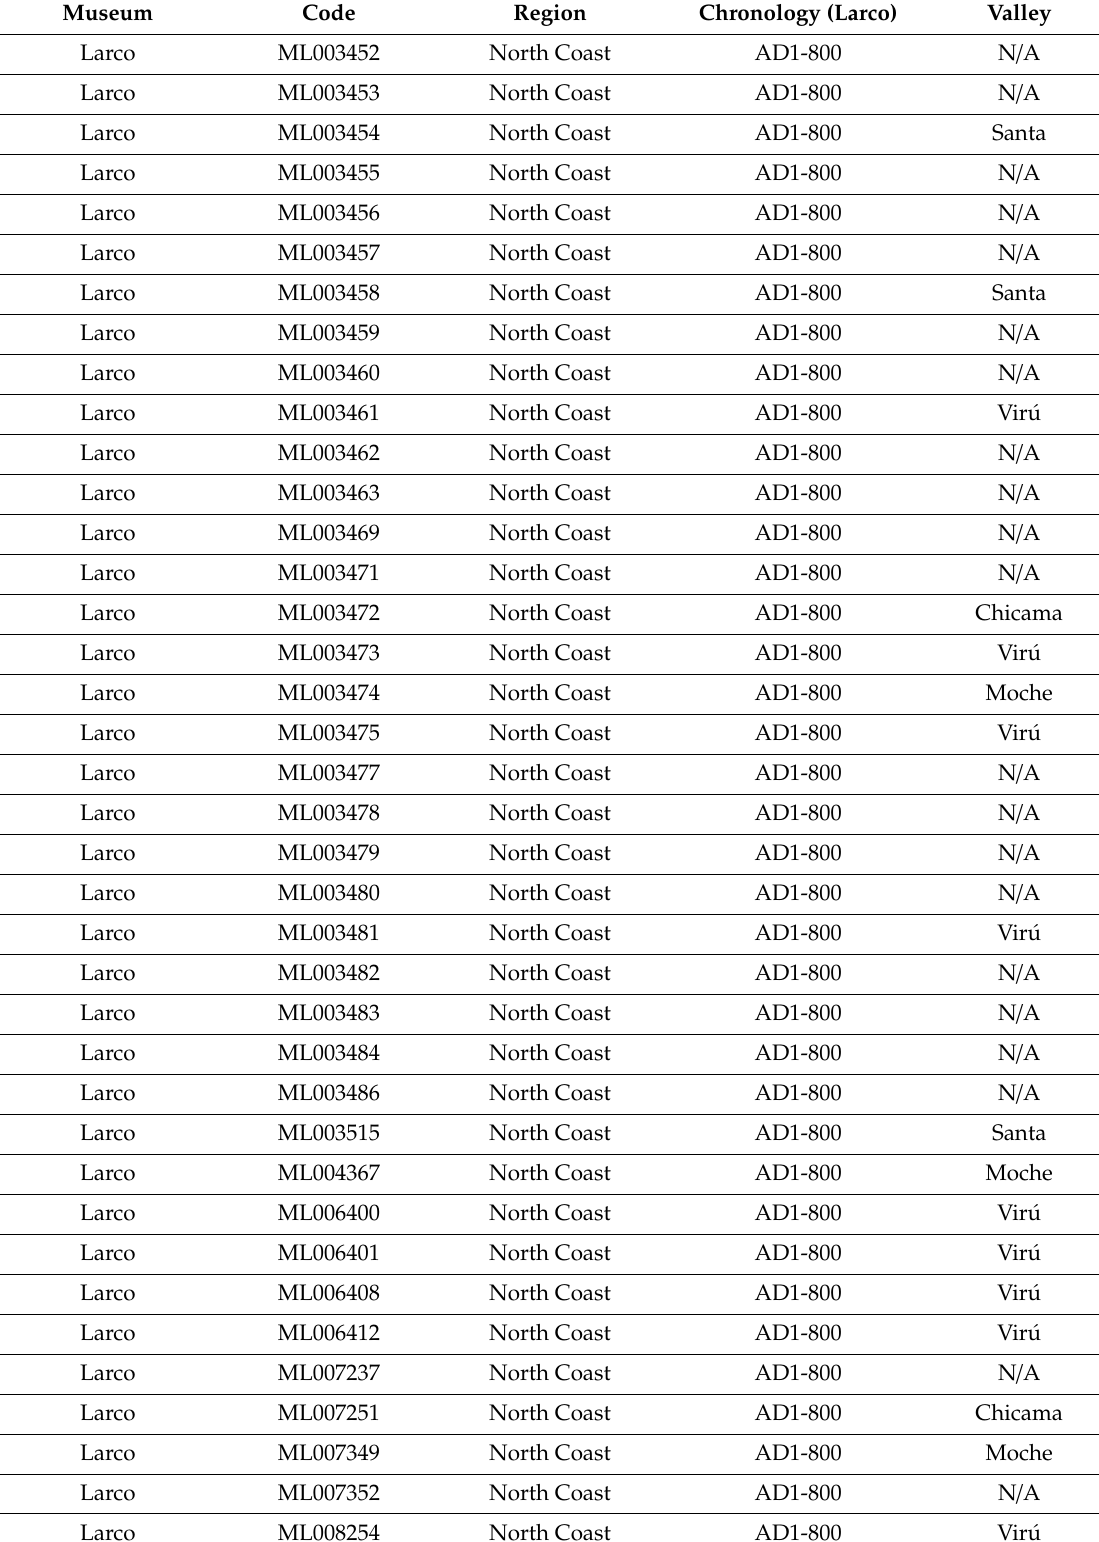
Table A1. Collection details for analysis of bat images indicating known information on date and